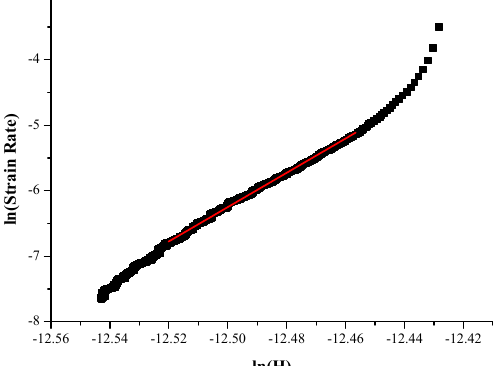
Figure 4. Linear fitting on steady creep area for actual stress exponent (n) slope calculation.